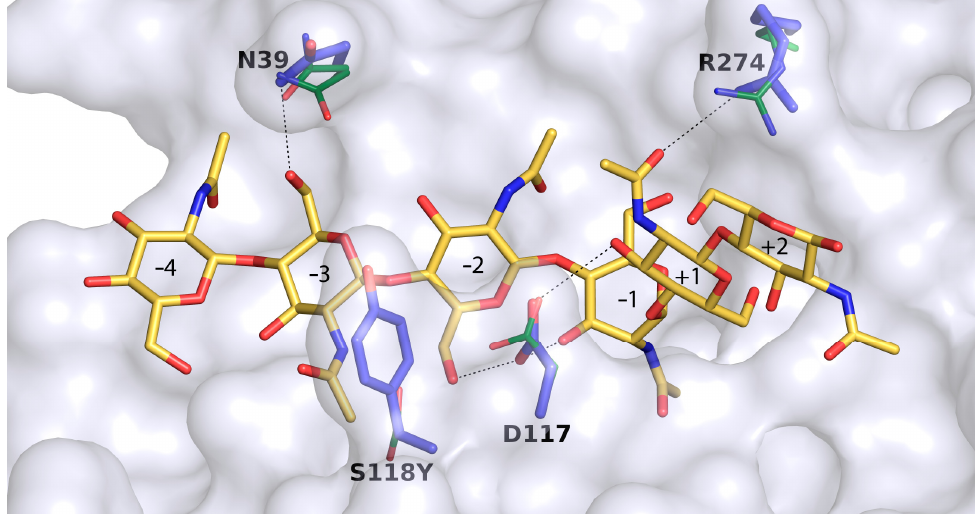
Figure 6. Molecular dynamics simulation of a putative Chit33-S118Y-NAG6 complex. Residues presenting conformational changes with respect to the Chit33-D165A/E167A-NAG4 complex are highlighted, showing the crystallographic position as green sticks.